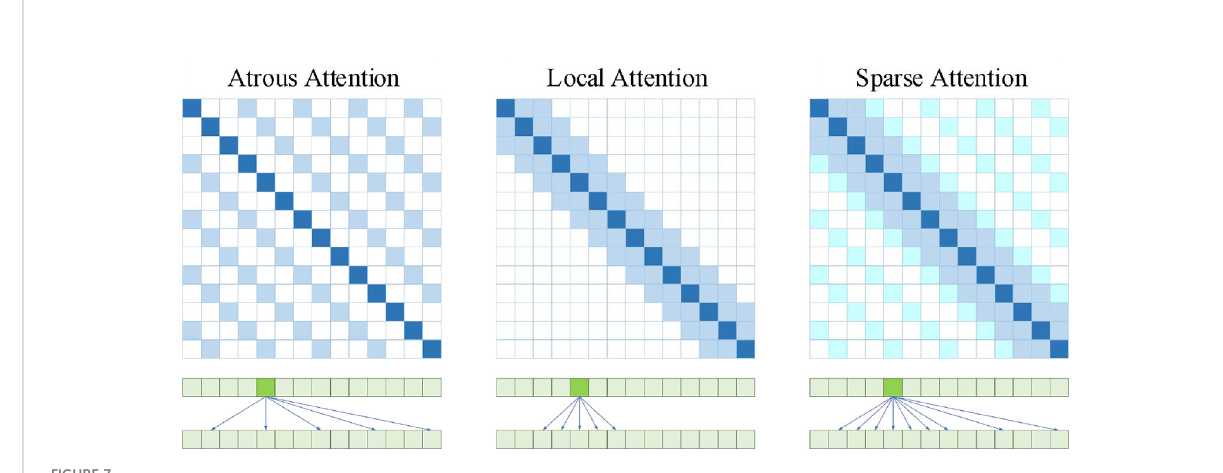
FIGURE 7 Attention matrix and correlation diagram of three kinds of Self Attention.